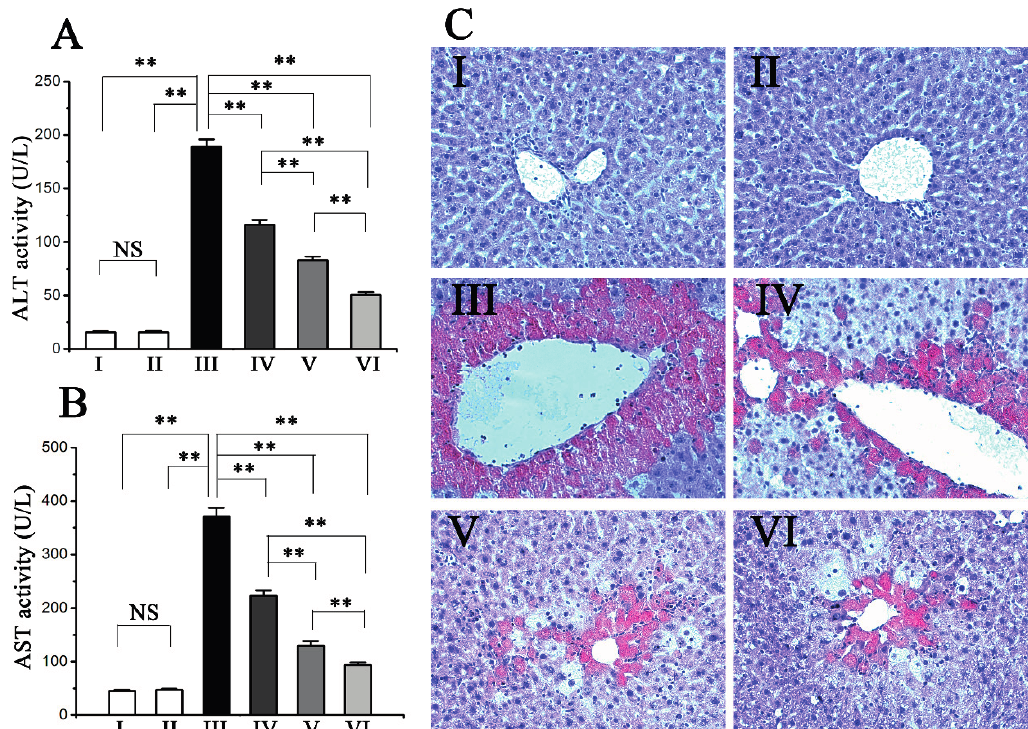
Figure 1. Pretreatment effects of procyanidin B2 on CCl 4 -induced hepatic injury. Serum ALT ( A ); AST ( B ) activities were measured; ( C ) Mouse liver sections stained with H & E to show histopathology of livers (magnification: 200×). Values expressed as mean ± SE in each group. NS: no significant, ** p < 0.01, n = 10. Animals were divided into following groups: I, normal control; II, procyanidin B2 control; III, model; IV, procyanidin B2 (25 mg·kg − 1 ) + CCl 4 ; V, procyanidin B2 (50 mg·kg − 1 ) + CCl 4 ; and VI, procyanidin B2 (100 mg·kg − 1 ) + CCl 4